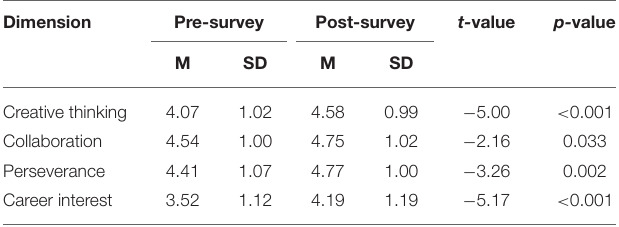
TABLE 2 | Results of paired sample t -test for pre- and post-surveys. Dimension Pre-survey